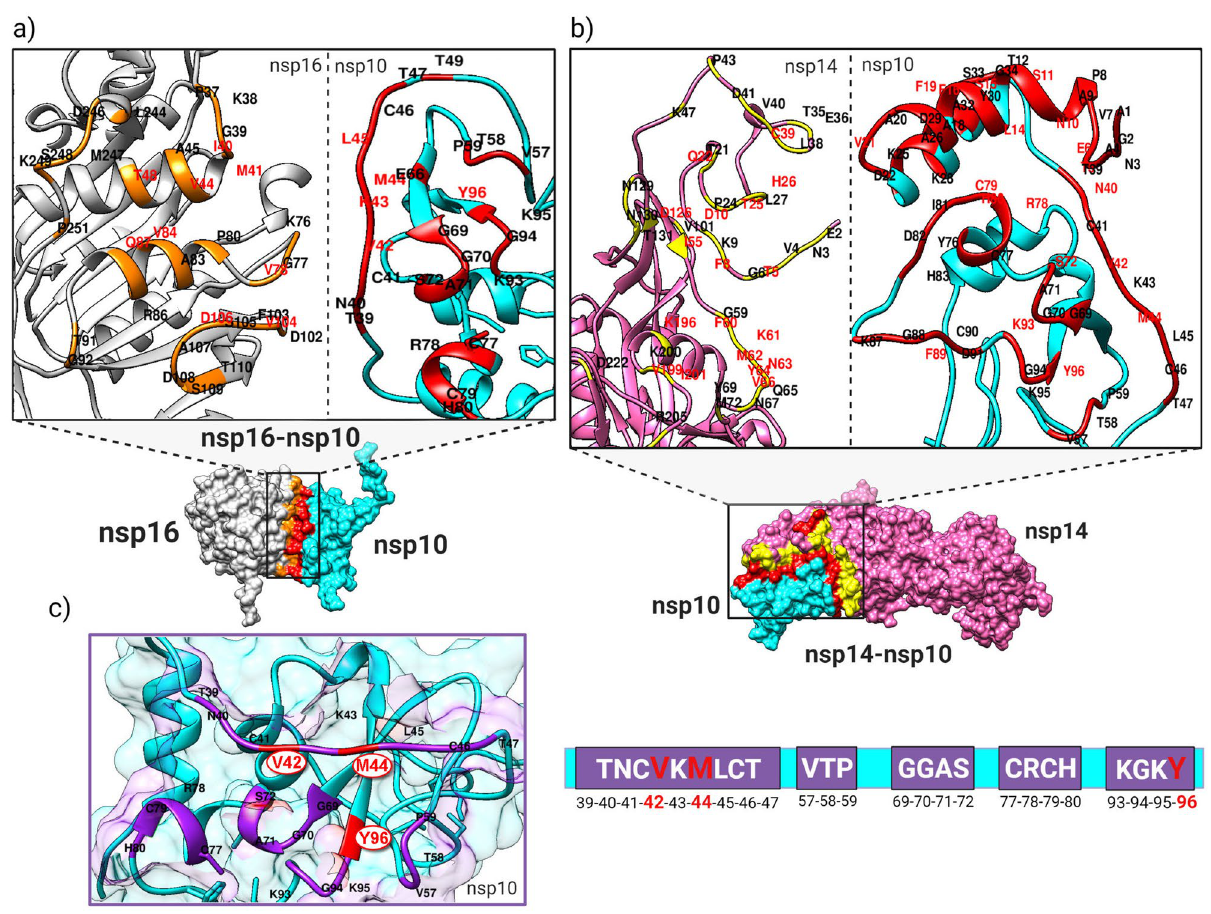
Figure 2. Analysis of the SARS-CoV-2 nsp16-nsp10 and nsp14-nsp10 protein–protein interfaces and hotspot residues. ( a ) The interfaces and hotspots were mapped to the nsp16-nsp10 structure at the protein–protein interfaces of nsp16 (gray) and nsp10 (cyan), which are colored orange and red, respectively. ( b ) The interfaces and hotspots at the protein–protein interfaces of nsp14 (magenta) and nsp10 (cyan) are colored yellow and red, respectively. Hotspot residues are shown in red labels. ( c ) The overlapping key interface (purple) and hotspot (red) residues of nsp10 (cyan), which interacted with both the nsp16 and nsp14